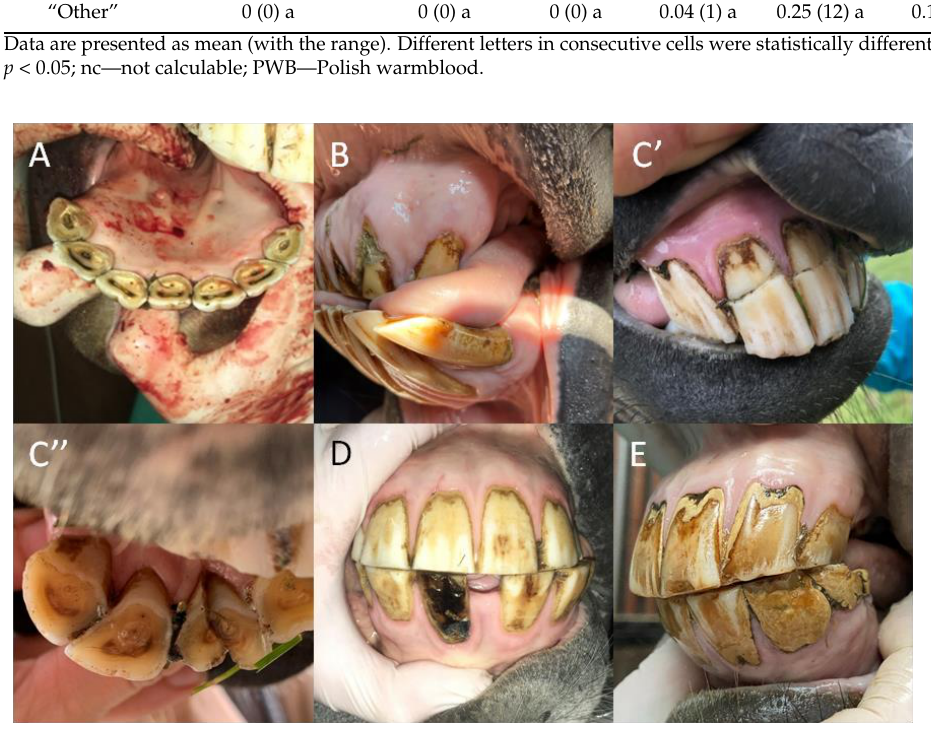
Figure 4. The samples of the dental diseases of the incisor teeth in horses. Supernumerary ( A ); loose teeth ( B ); fractures (( C ): transverse fracture, ( C ’ ); sagittal fracture, ( C ” )); caries ( D ); and calculus ( E ).